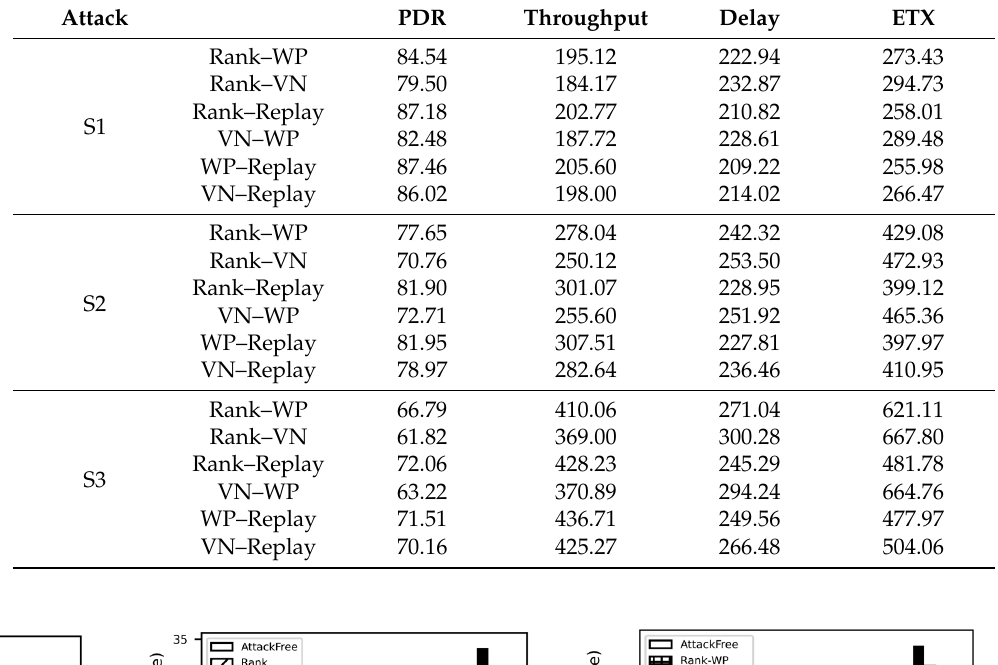
Table 6. QoS Performance Results: Hybrid-Attack Scenario.